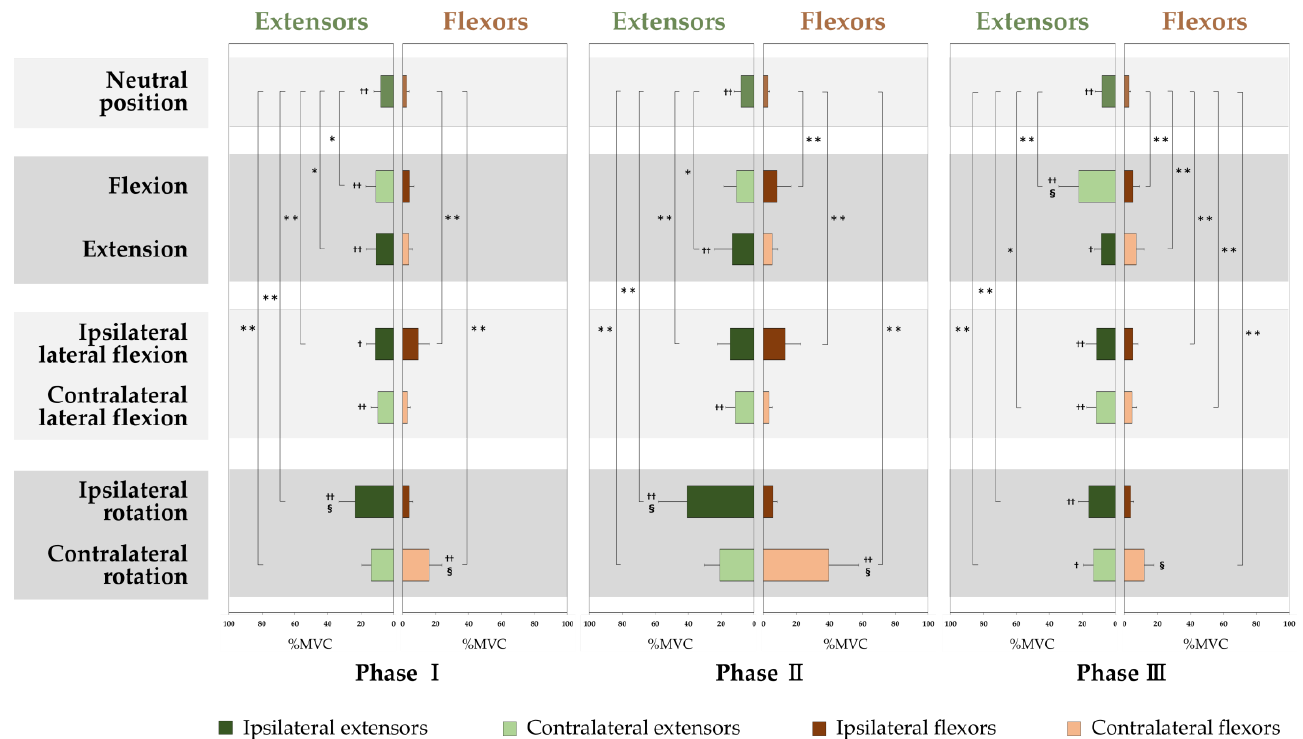
Figure 2. The percentage of maximal voluntary contractions (%MVC) (mean ± standard deviation) in each phase of the cervical extensors and flexors in each motion. There were significant differences in the %MVC when compared with the neutral position (* p < 0.05, ** p < 0.01) and between the corresponding extensors and flexors ( † p < 0.05, †† p < 0.01). The largest %MVCs among all motions in each phase for the extensors and flexors, respectively, are indicated by “§” ( p < 0.01).